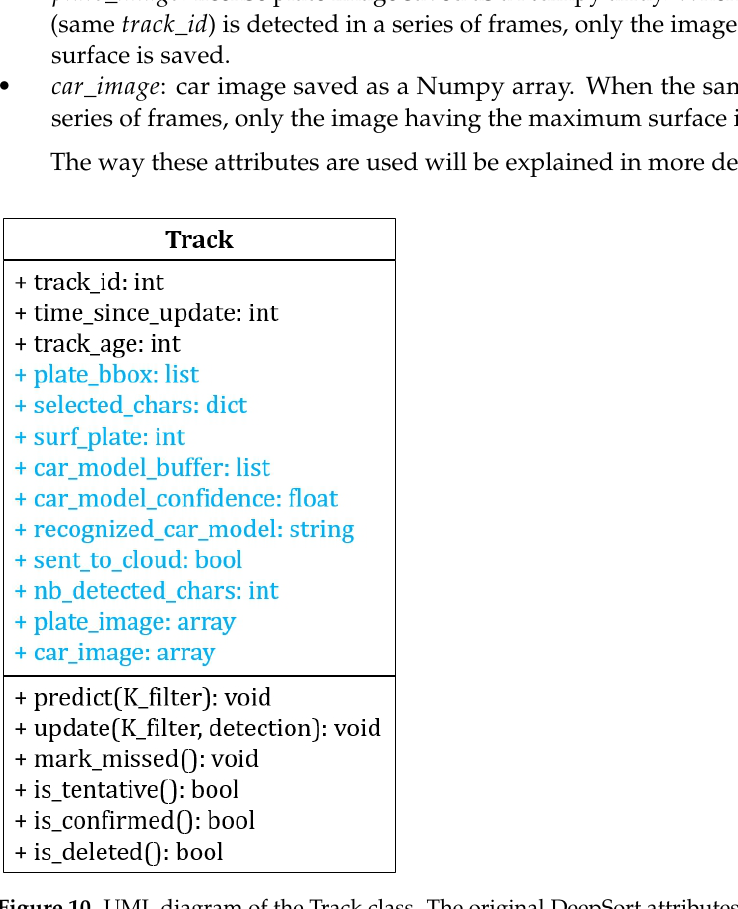
Figure 10. UML diagram of the Track class. The original DeepSort attributes and methods are shown in black, while the attributes that we added to integrate the tracker with our system are shown in